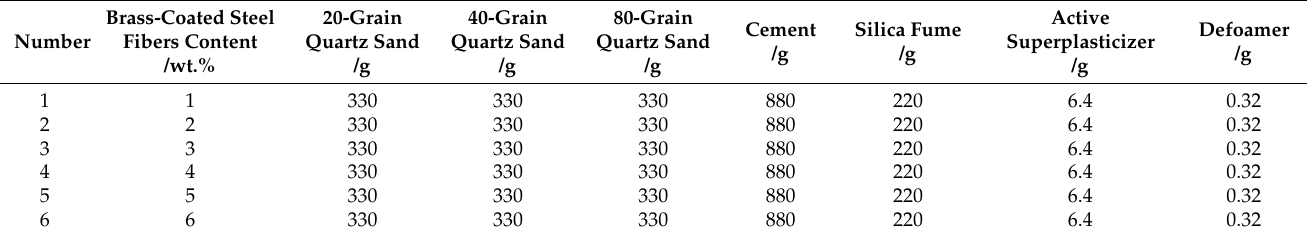
Table 1. Weight ratios of the material ingredients for the ultra-high-performance concrete